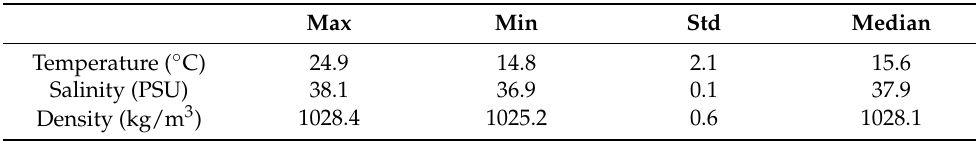
Table 3. Hydrological main statistical